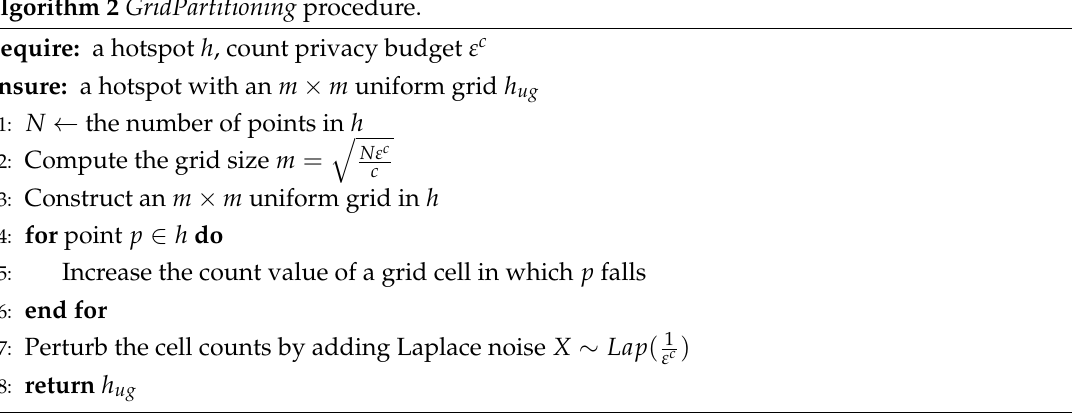
Algorithm 2 GridPartitioning